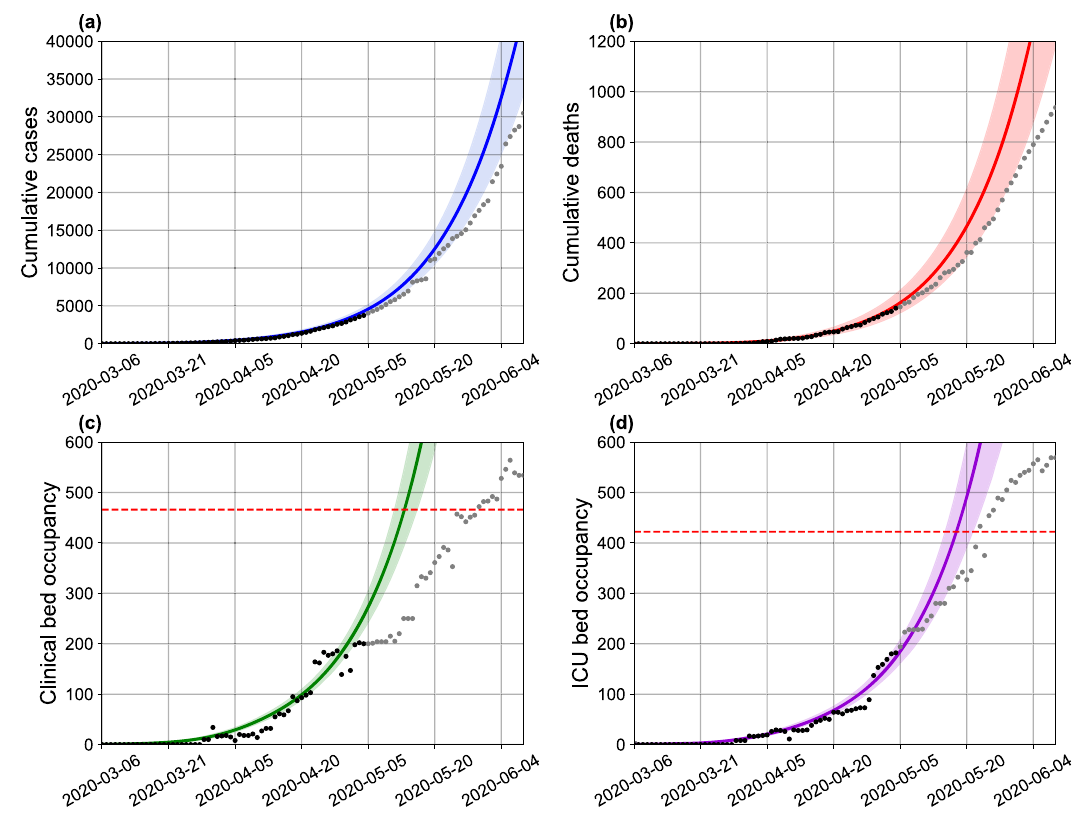
Fig. 6 Real-time comparison between the modeling analysis in Bahia and reported data updated up to June 4, 2020. ( a ) Cumulative number of cases; ( b ) cumulative number of deaths; daily ( c ) clinical, and ( d ) ICU bed requirements in the state of Bahia. The model was fi tted based on data up to May 4, 2020, represented by black dots, as shown in Fig. 3. The shaded error bands represent 95% con fi dence intervals of the mean calculated using the weighted non-parametric bootstrap method. Gray dots depict the newly available data up to June 4, 2020. The horizontal red dashed lines in panels c and d represent, respectively, the number of beds for clinical hospitalization (466 beds) and ICUs (422 beds) available on May 4, 2020. Raw data from March 6 to June 4, 2020 are shown in this